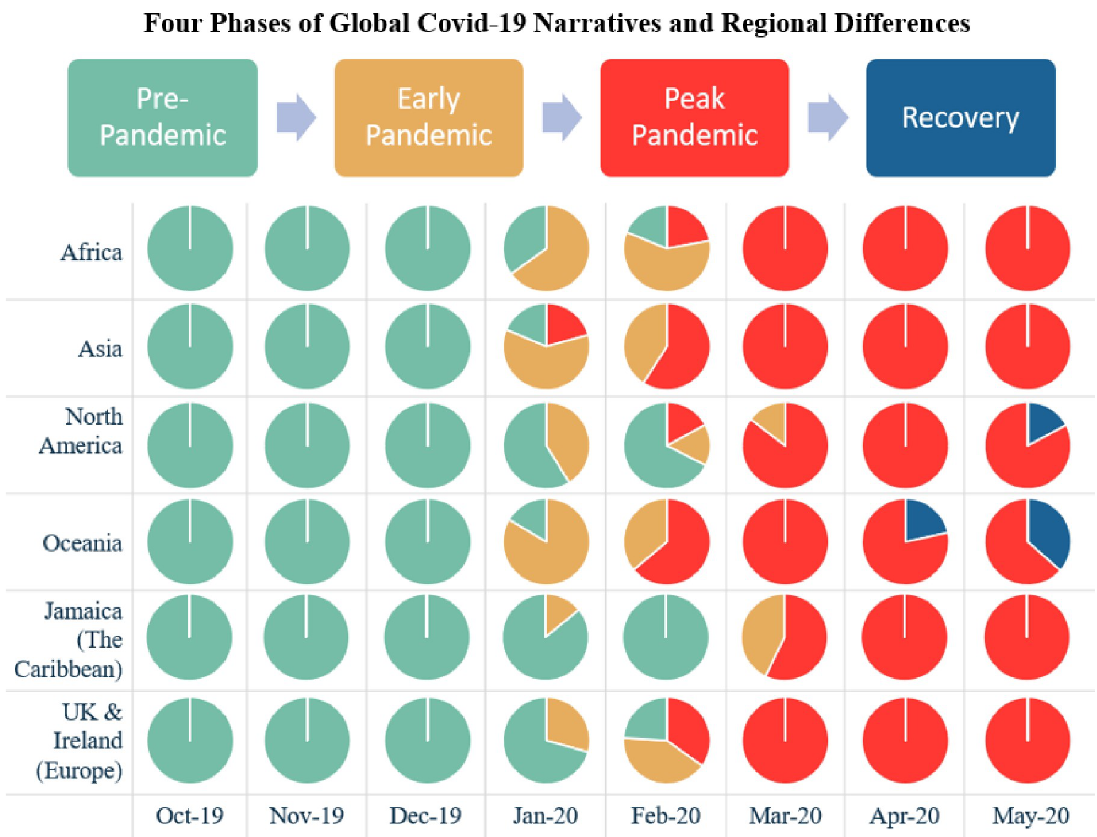
Fig 3. Global convergence and regional divergence in Covid-19 narratives across six continents. Pre-pandemic narratives (Oct’19– Dec’19; coded ‘green’) were divergent across regions with Africa focused on infectious diseases (e.g., monkeypox), Asia on dengue fever, Oceania on plant-related fungal diseases and North America on Lyme disease and AIDS. Early and Peak Pandemic evidenced a global convergence, reflecting the omnipresence of Covid-19 globally. The brief transition from early (coded ‘orange’) to peak (coded ‘red’) pandemic narratives underscored the pandemic’s rapid spread across six continents. Emerging from the embers of the pandemic’s peak are nascent recovery narratives (coded ‘blue’) that are regionally divergent—Oceania focused on hope and an uncertain future while North America focused on re-opening the economy and tackling